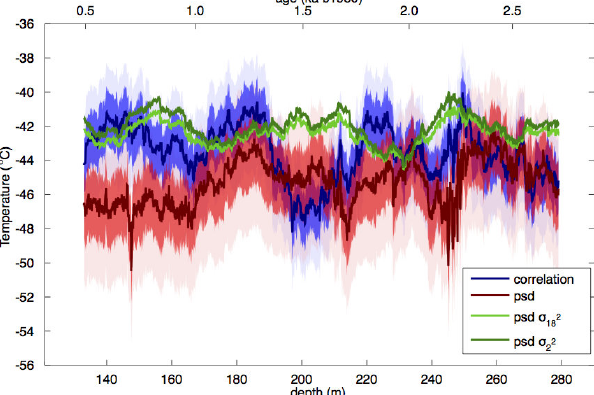
Figure 11. Local surface temperature reconstructions based on the differential diffusion lengths given in Fig. 10 and the model de- scribed in the main text. The shaded bands give the 1 σ and 2 σ un- certainties and are based on the uncertainty in the differential dif- fusion lengths. Also given are temperature reconstructions obtained with the PSD method applied to single isotopes (green lines). The recent measured annual temperature at EDML is − 44.6 ◦ C. The age scale on the top x axis is the AICC2012 age